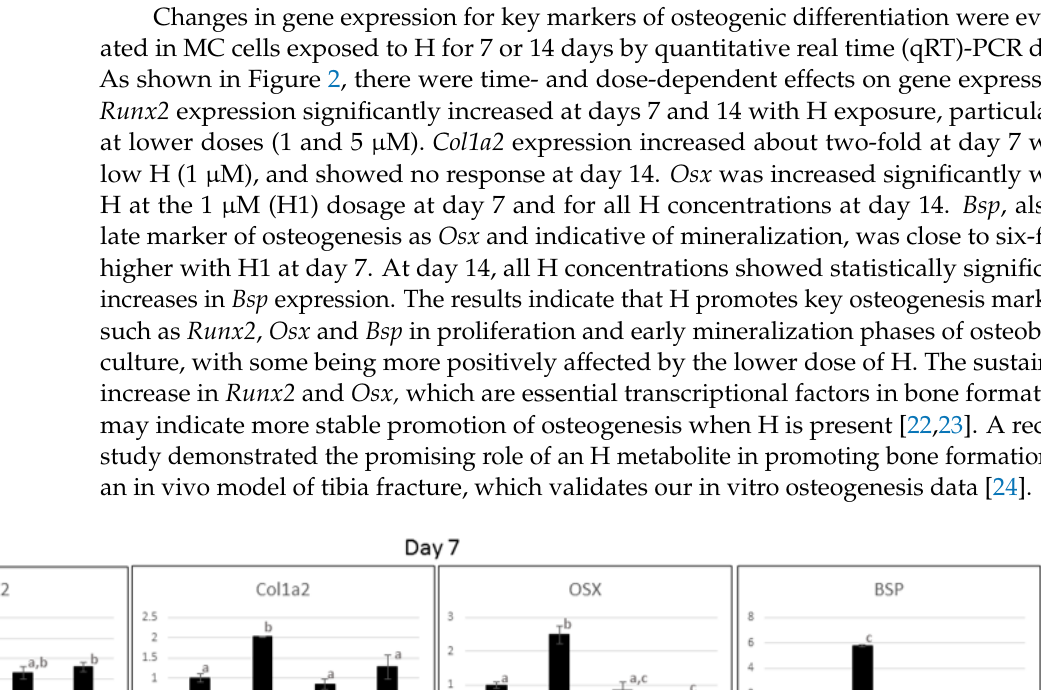
Figure 1. MC3T3-E1 cell proliferation ( A ) and viability ( B ) upon treatment with hesperidin (H) at concentrations of 1, 5 (H5) and 100 (H100) μM show no significant differences ( n = 3/group, p > 0.05).